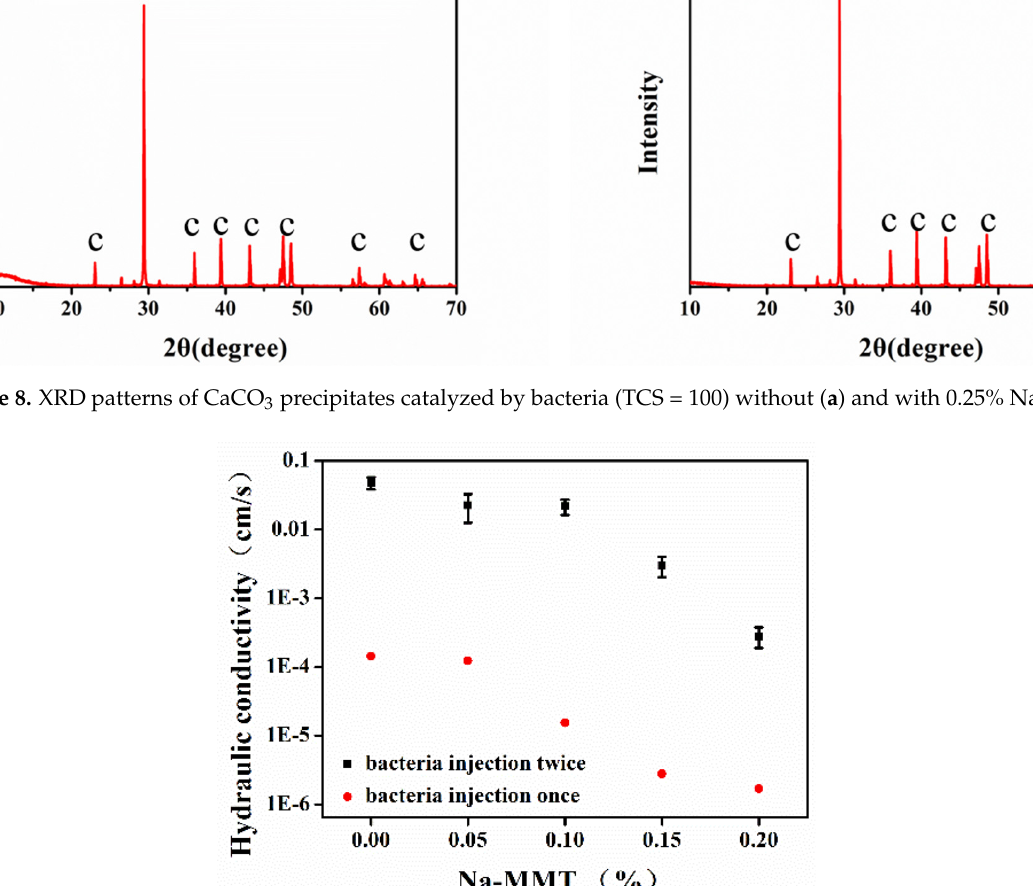
Figure 9. The hydraulic conductivity of consolidated sandy soil with different Na-MMT concentrations. The images of SMEs show that cementation mainly occurred at the contact points between the sandy soil particles (Figure 10). Meanwhile, a small amount of CaCO 3 was adsorbed on the surface of sandy soil particles (Figure 10a). The reason for this was the low adsorption capacity of the bacteria on the surface of the sandy soil [41]. Meanwhile, the large gap between the sandy soil particles was not filled tightly, which may have been due to the low output of CaCO 3 between the sandy soil gap (Figure 10b). Thus, good hydraulic conductivity was achieved. The SEM images of the consolidated sandy soil by the MICP process with Na-MMT are shown in Figure 10c,d. These images show that CaCO 3 precipitates tightly filled the voids between the sandy soil particles in the presence of Na-MMT. Na-MMT was not only a carrier for the formation of the CaCO 3 precipitates, but also enhanced the yield of CaCO 3 precipitates at the contact points. That is why there was a denser structure between the sandy soil particles during the MICP process in the presence of Na-MMT. Thus, a lower hydraulic conductivity can be achieved because of the more pronounced bio-clogging and bio-cemented